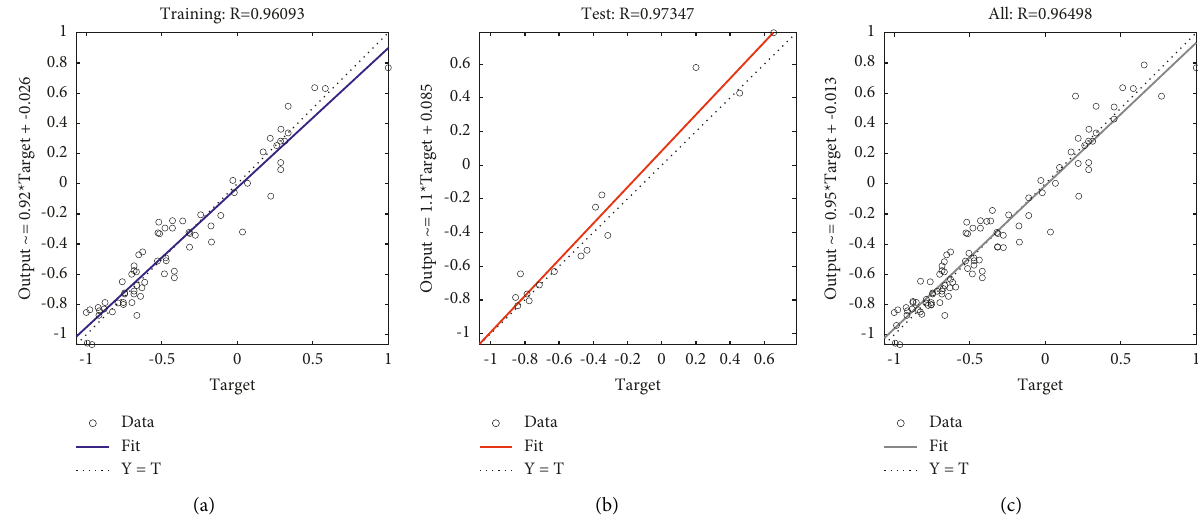
Figure 5: Dynamic changes of the metrics: (a) training set, (b) test set, and (c) all data sets. Table 8: Training value and error analysis of benchmark land